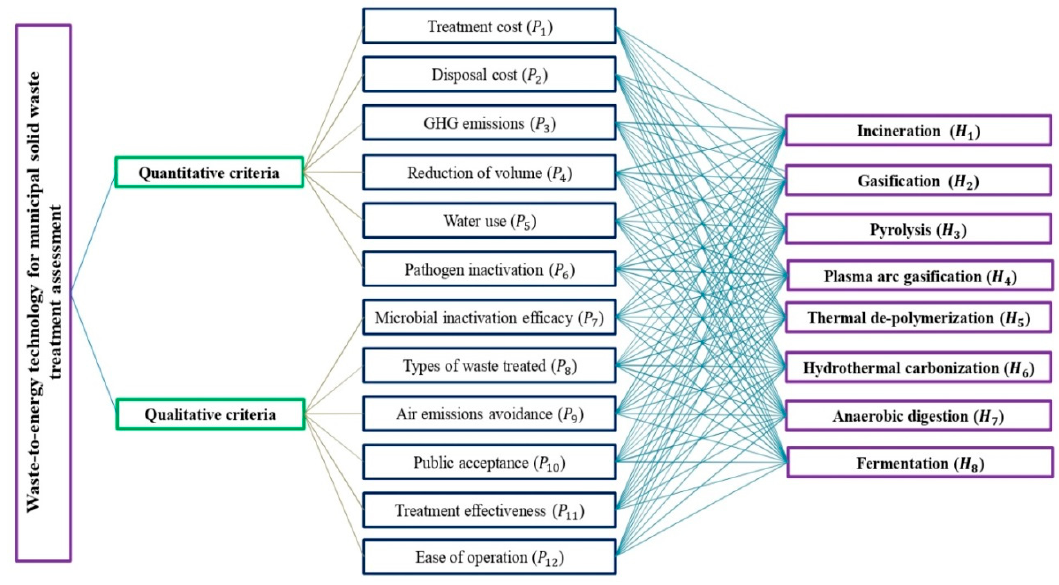
Figure 3. Hierarchical structure of WTE technology for MSW treatment assessment.